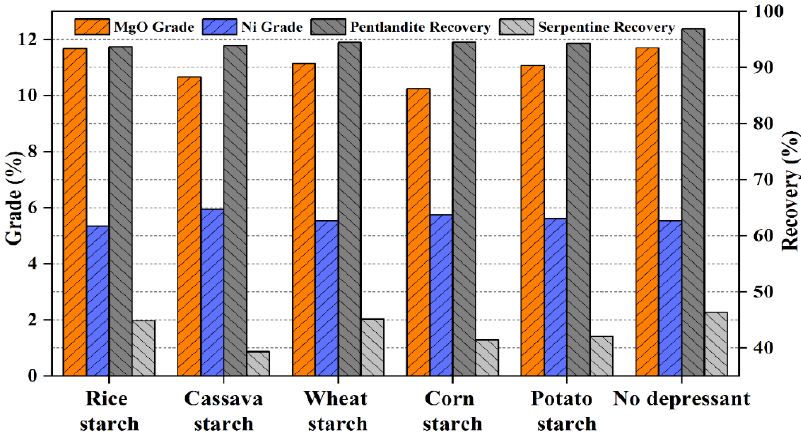
Figure 6. Recovery and grades of concentrate in the flotation of artificial mixed mineral with